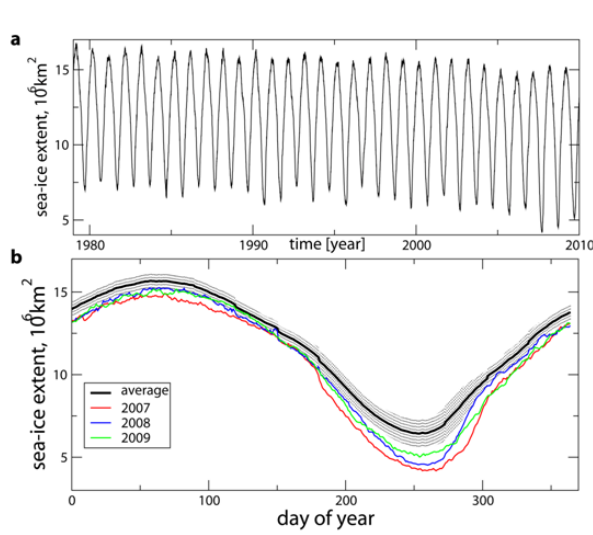
Fig. A1. Arctic sea-ice extent from satellite data. (a) Arc- tic sea-ice extent from Eisenman (2010) and available at ftp://ftp.agu.org/apend/gl/2010gl043741. (b) The mean annual cy- cle of the extent data over 1979–2009 (solid line, shaded area de- notes 2 σ error bars), together with the last three anomalous years.